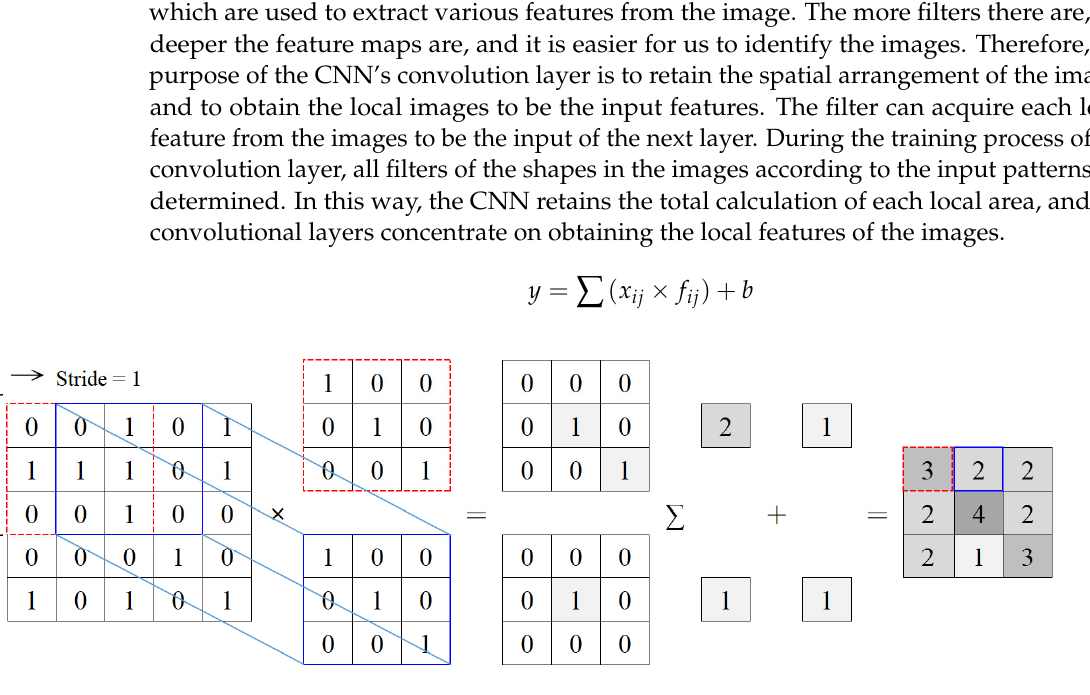
Figure 2. Example of average pooling with a 2 × 2 filter and stride of 1.